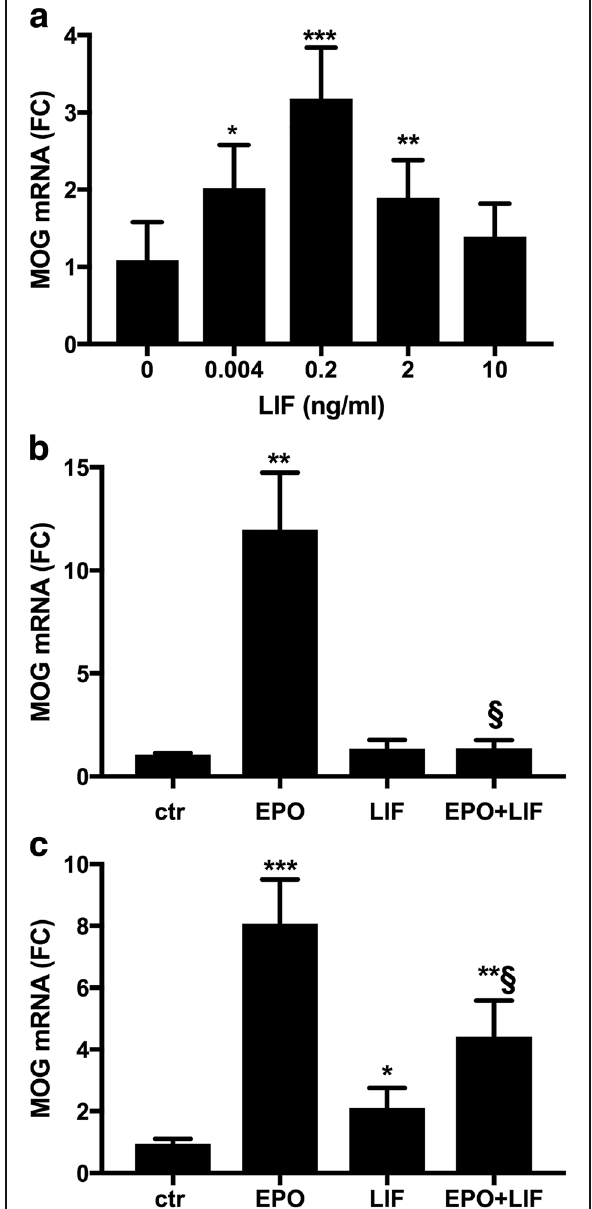
Fig. 1 LIF induces MOG mRNA with a bell-shaped dose-response curve and inhibits EPO-induced MOG expression. Cells cultured for 1 day in growth medium (GM) were switched to differentiation medium (DM). After 3 h in DM the cells were treated with the indicated concentrations of LIF ( a ) or with or without EPO (10 ng/ml) and LIF (10 ng/ml, panel b ; 0.2 ng/ml, c ). MOG gene expression was measured by RT-qPCR at day 3 of differentiation. Results are expressed as fold change (FC) vs one of the control samples (no LIF in panel a and ctr in b and c ). Data are the mean±SD of seven samples from two independent experiments assayed in duplicate ( a ) or of quadruplicate samples assayed in duplicate and representative or five ( b ) or two ( c ) independent experiments; * P <0.05, ** P <0.01, *** P <0.001 vs control; § P <0.01 vs EPO alone by two-tailed Student ’ s t-